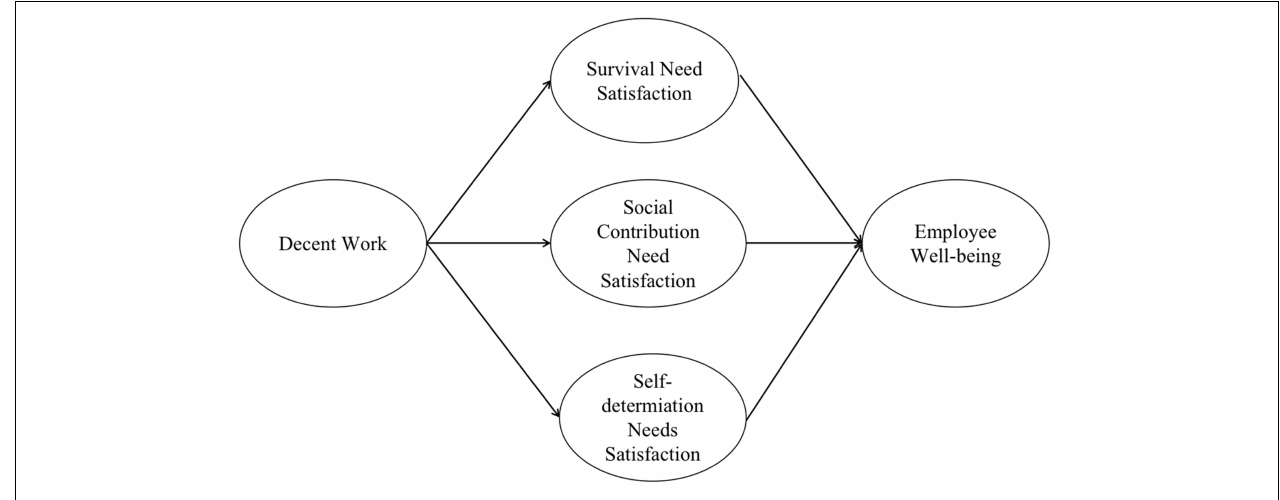
FIGURE 1 | Research model.